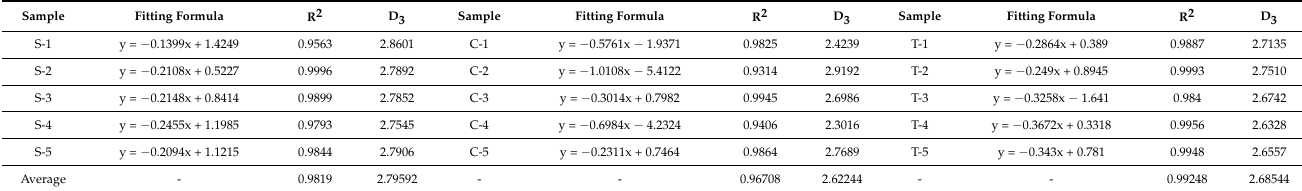
Table 3. FHH fractal model and fractal dimension of shale, coal, and tight sandstone